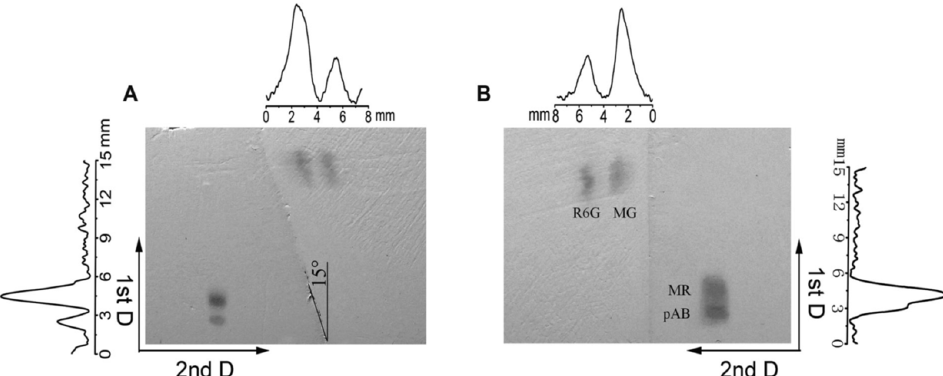
Figure 8. 2-D TLC separation of four dyes with the use of dual-phase layer consisting of hydrophilic hydrolyzed poly(GMA-co-EDMA) and hydrophobic poly(BMA-co-EDMA) parts: ( A ) Slant bound- ary 15°, ( B ) slant boundary 0°. Mobile phase: (First dimension) ethyl acetate/ethanol/water 4:5:9 v/v/v , (second dimension) 10 mM NaCl methanol solution. Reprinted with permission of Jhon Wiley and Sons from [51].